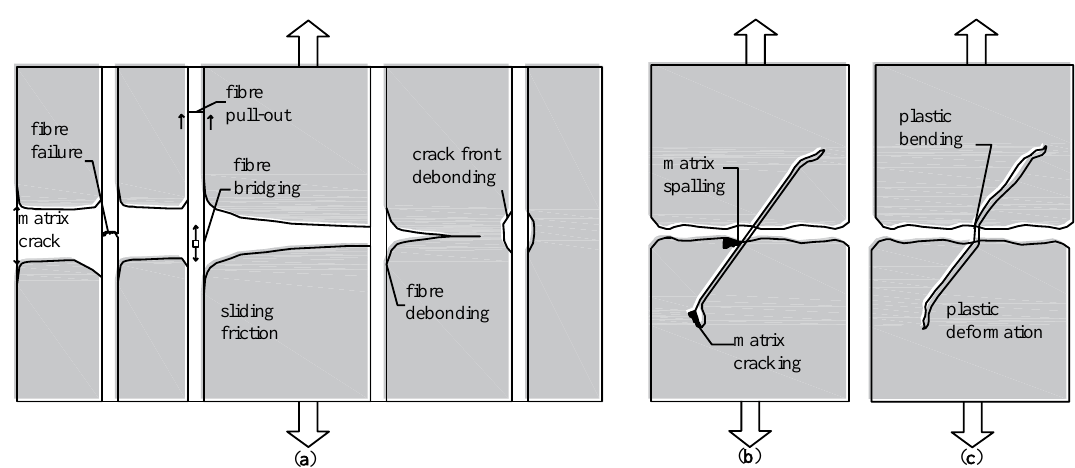
Figure 2. ( a ) A schematic illustration of some of the toughening effects and crack front debonding, the Cook–Gordon effect [14], and debonding and sliding in the crack wake; ( b ) matrix spalling and matrix cracking; ( c ) ductile bending (deformation) of inclined fiber during pull-out—both at the crack and at the end-anchor